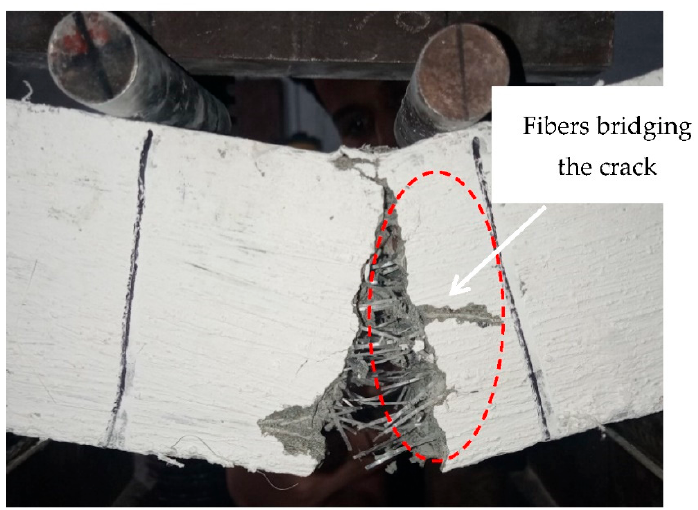
Figure 9. Fibers bridging the crack that appeared in the central third of the specimen tested in flex ‐ ure.